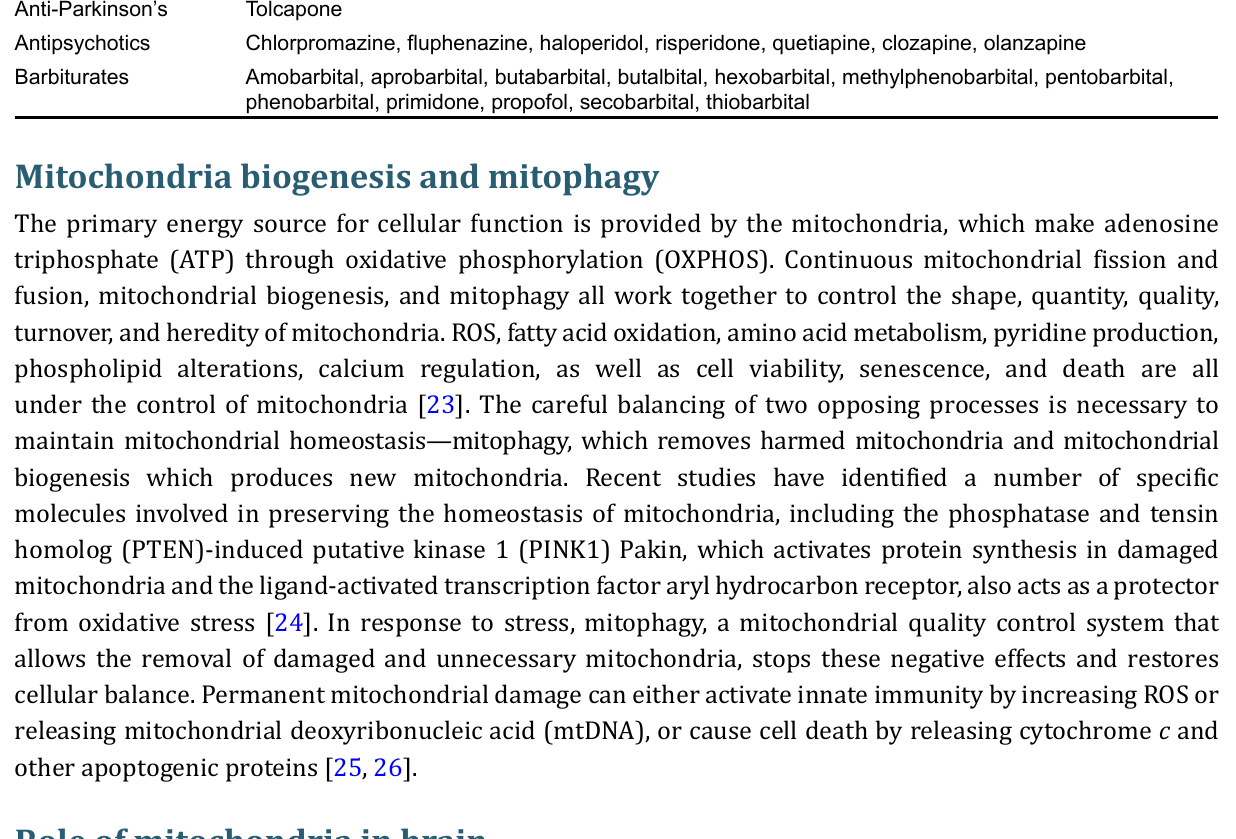
Table 2. Drug-induced mitochondrial dysfunction Drugs class Drugs Alcoholism medications Disulfiram Anti-anxiety Alprazolam, diazepam Anti-dementia Tacrine, galantamine Antidepressants Amitriptyline, amoxapine, citalopram, fluoxetine, Symbyax, Sarafem, Fontex, Foxetin, ladose, Fluctin, prodep, Fludac, oxetin Antiepileptic Valproic acid, mood stabilizers lithium Anti-Parkinson’s Tolcapone Antipsychotics Chlorpromazine, fluphenazine, haloperidol, risperidone, quetiapine, clozapine, olanzapine Barbiturates Amobarbital, aprobarbital, butabarbital, butalbital, hexobarbital, methylphenobarbital, pentobarbital, phenobarbital, primidone, propofol, secobarbital,